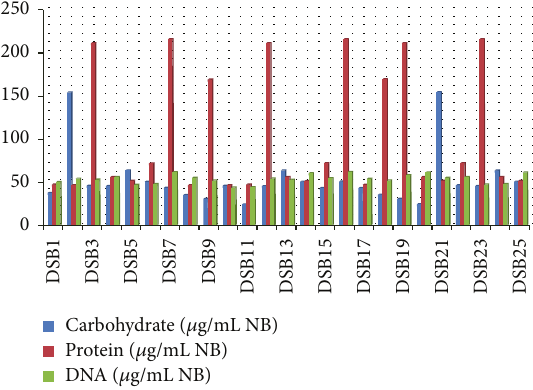
Figure 6: Total carbohydrate, protein, and DNA content of the Bacillus spp. isolated from the coastal areas of Digha, West Bengal,